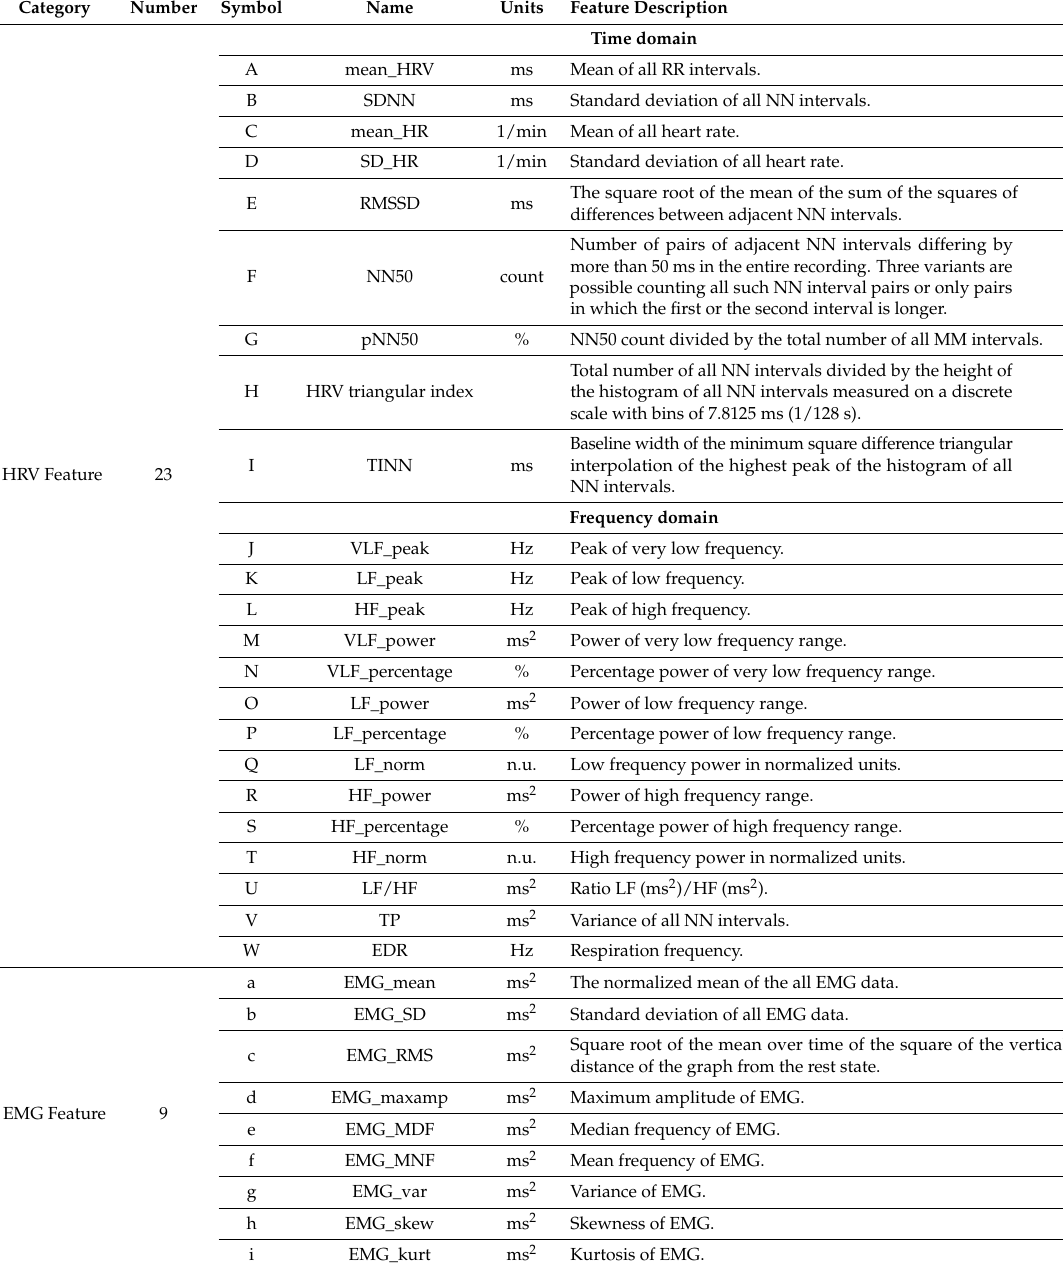
Table 3. Description of the 32 extracted